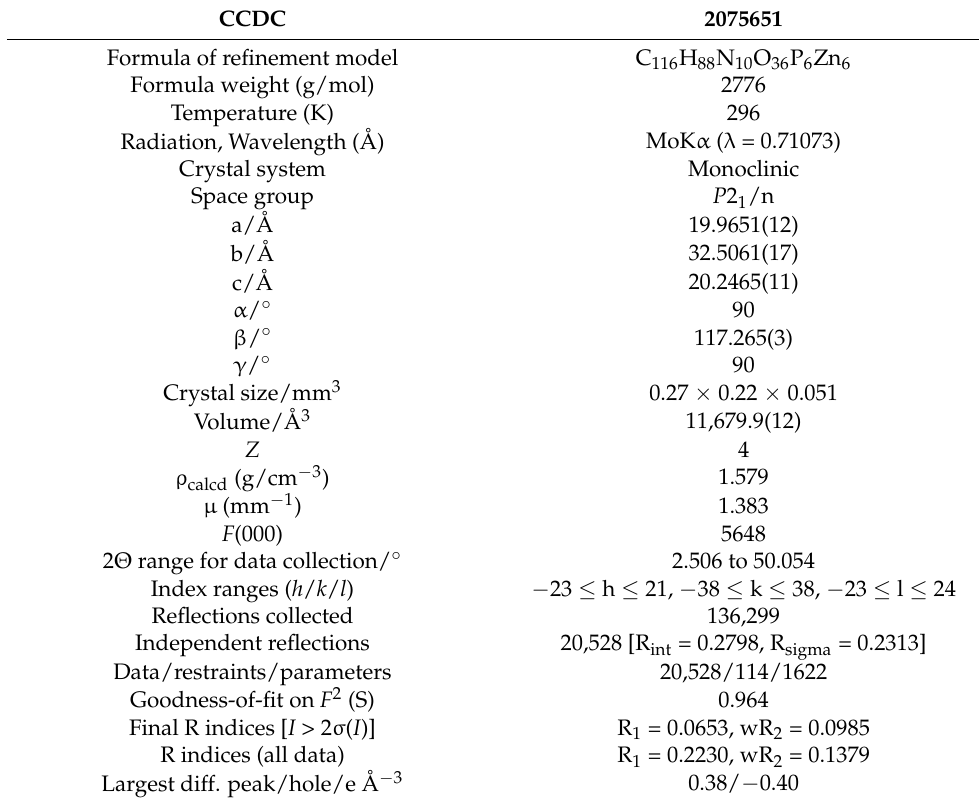
Table 1. Crystal data and structure refinement details for